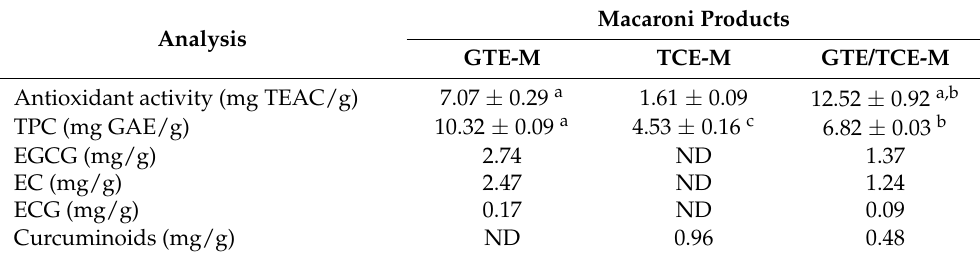
Table 1. Antioxidant activity, TPC, catechin and curcuminoid contents were all present in the three macaroni products.